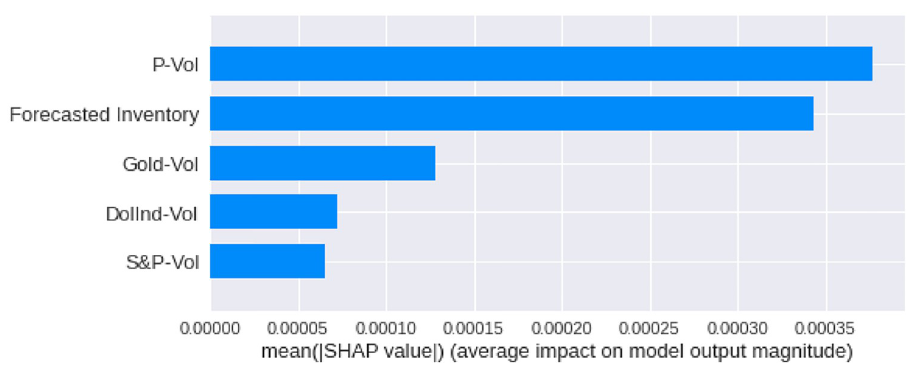
Fig 18. Mean Shapley values for the current day using Nadam